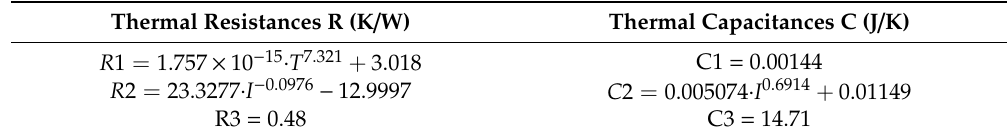
Table 1. Element values of the parametrized Cauer CTM for LED with the thermal pad